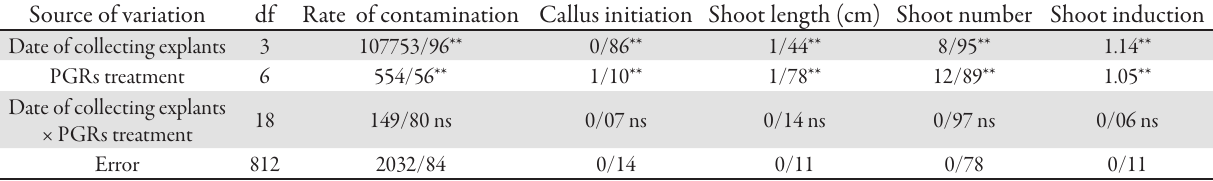
Tab. 2. Summary of treatment interaction as determined analysis of variation for shoot proliferation Source of variation